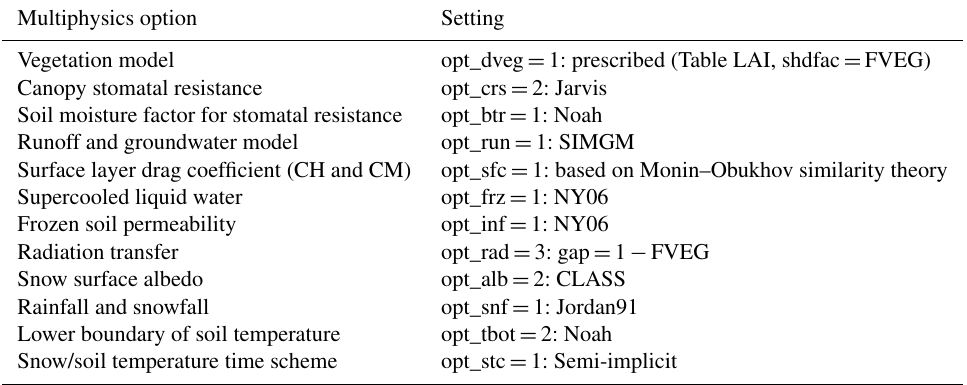
Table 1. Settings of the multiphysics options used in the Noah-MP simulation. Multiphysics option Setting Vegetation model Canopy stomatal resistance Runoff and groundwater model Surface layer drag coefficient (CH and CM) Supercooled liquid water Frozen soil permeability